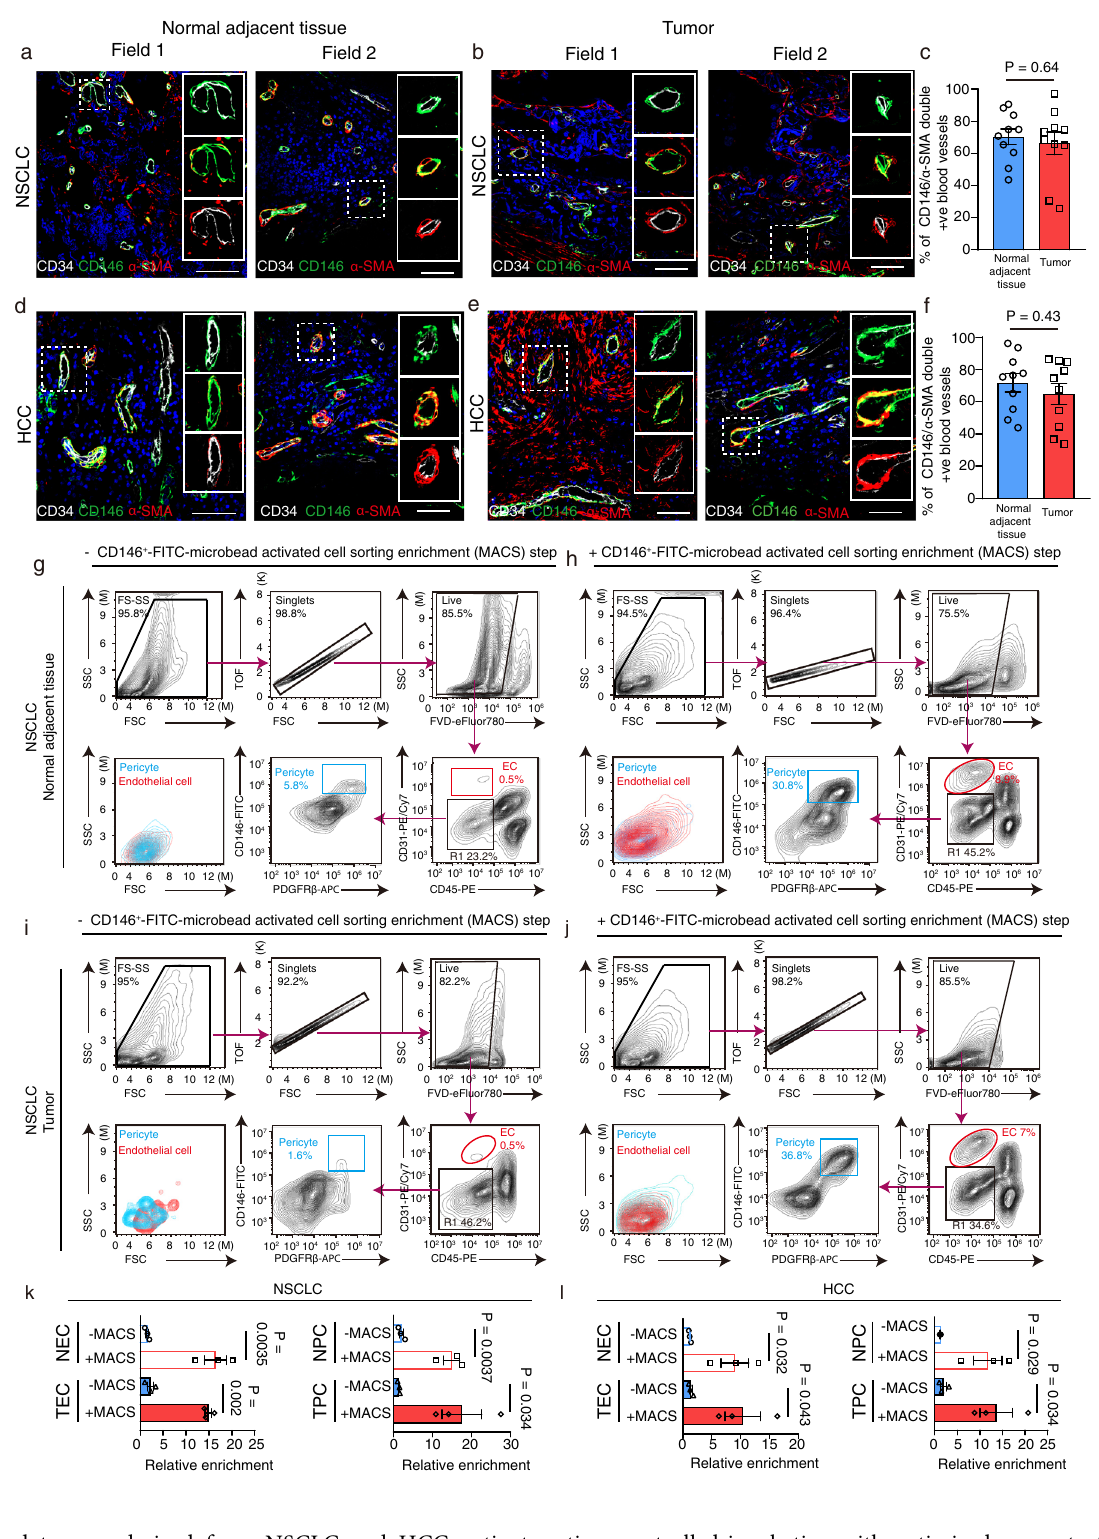
time-controlled incubation with optimized amount of collage- nase and DNase I. Characterization of the isolated pericytes from normal adja- cent tissues and tumors derived from NSCLC and HCC patients . To con fi rm the purity of our isolated pericytes derived from normal adjacent tissues and tumors, we performed fl